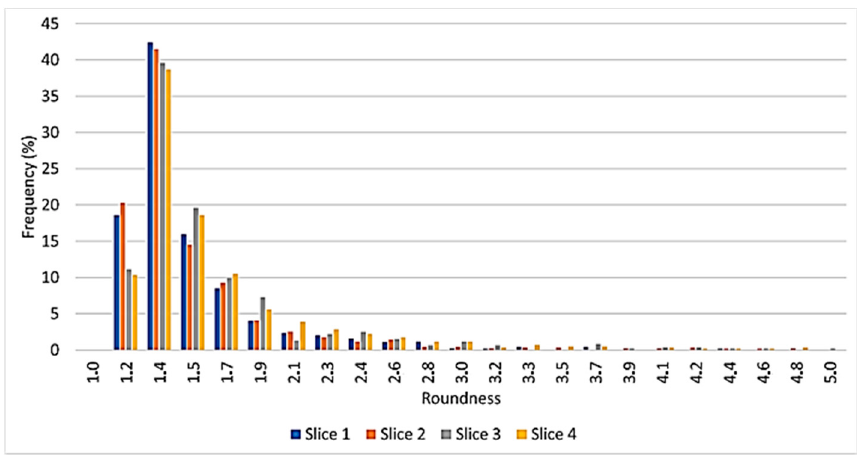
Figure 7. Distribution of cell size. Figure 8. Distribution of cell roundness.